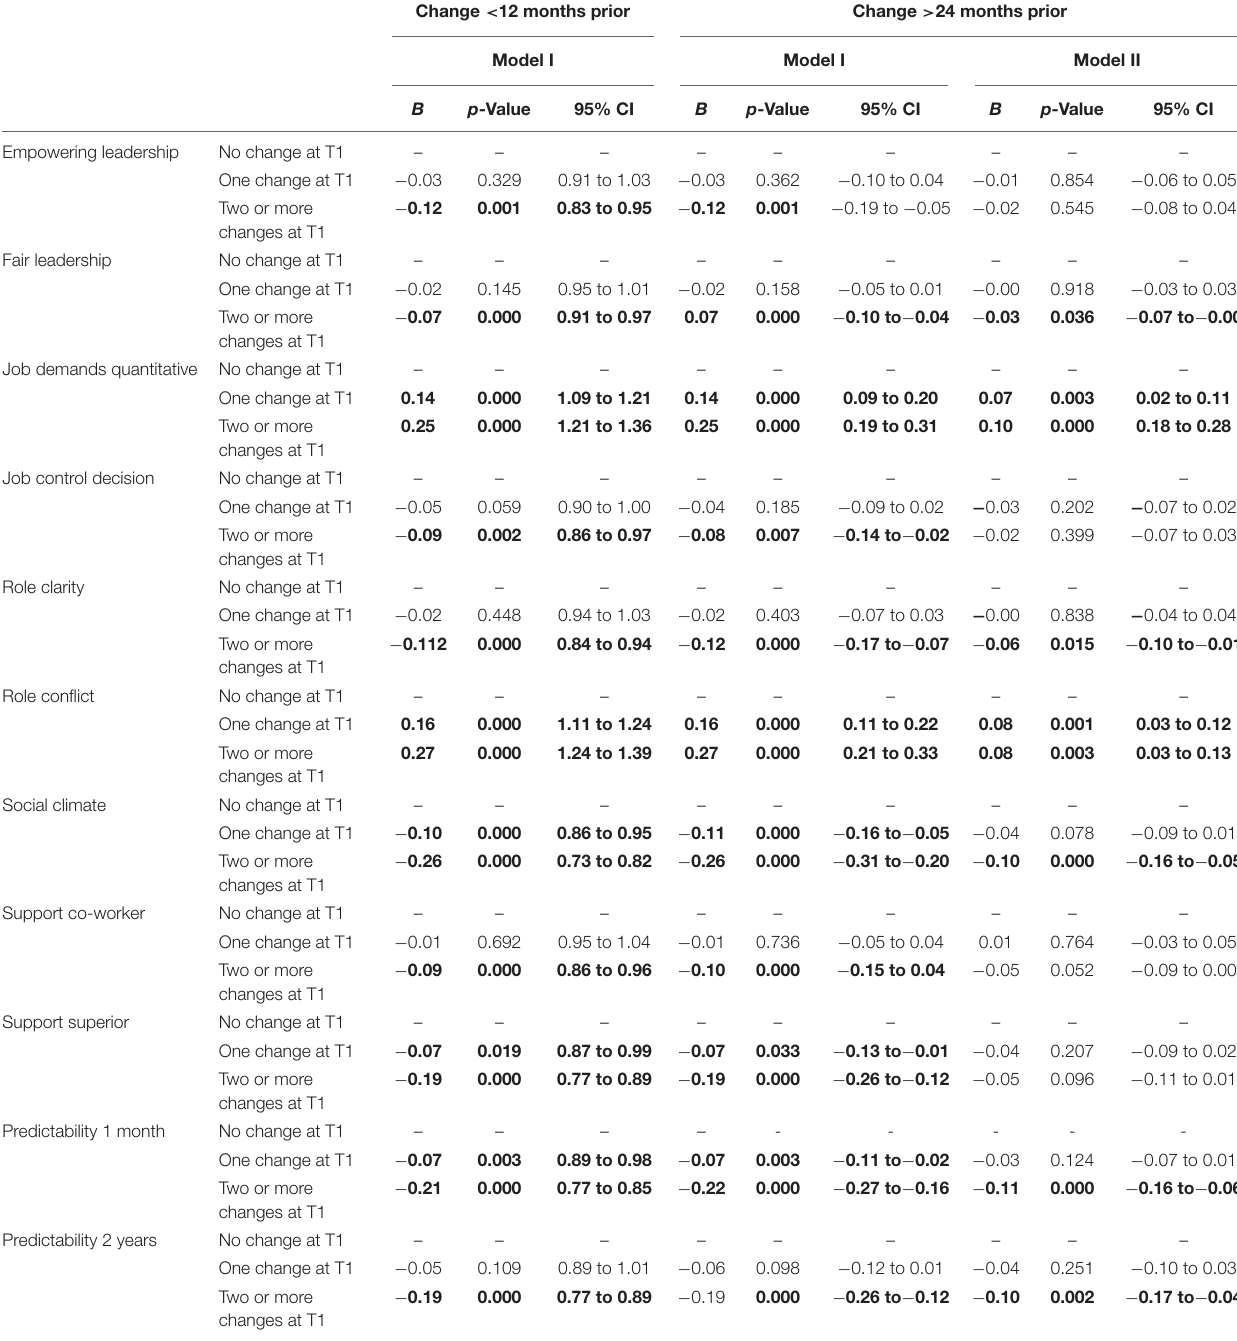
TABLE 6 | Multiple organizational changes (at